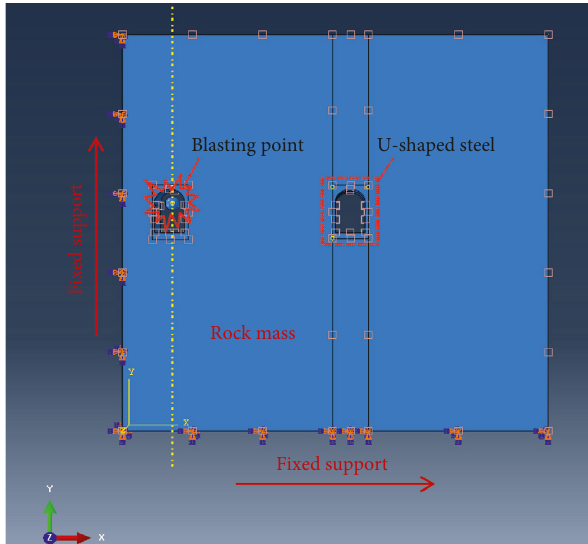
Figure 15: Blasting disturbance model. The red dashed line partly represents the U-shaped steel supporting tunnel, 9m from the explosion point. The blue represents the rock mass, and the model boundary is